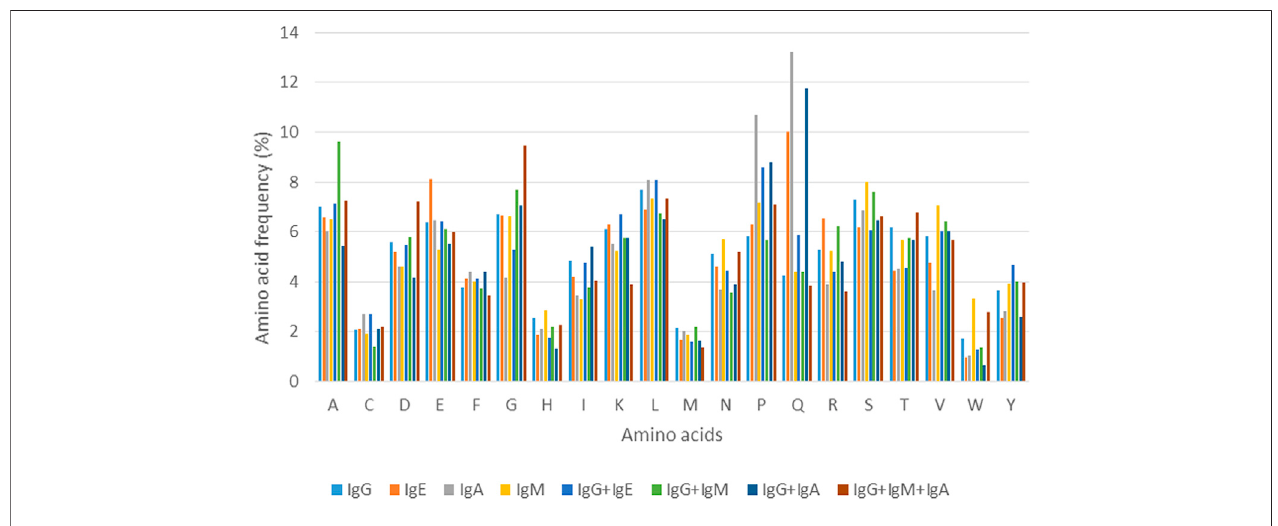
FIGURE 2 | Distribution of amino acids in various epitope classes.